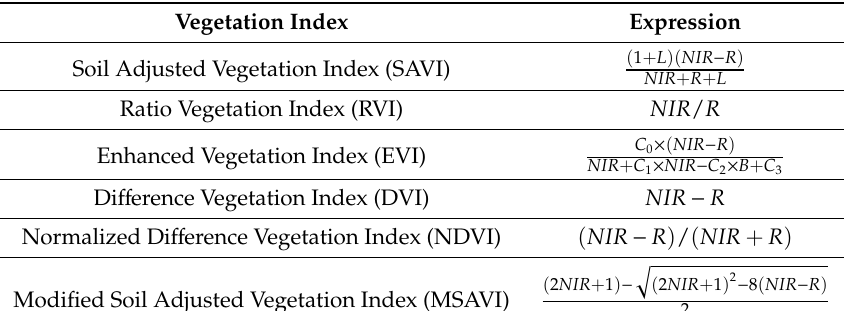
Table 2. Selected six vegetation indices and their mathematical